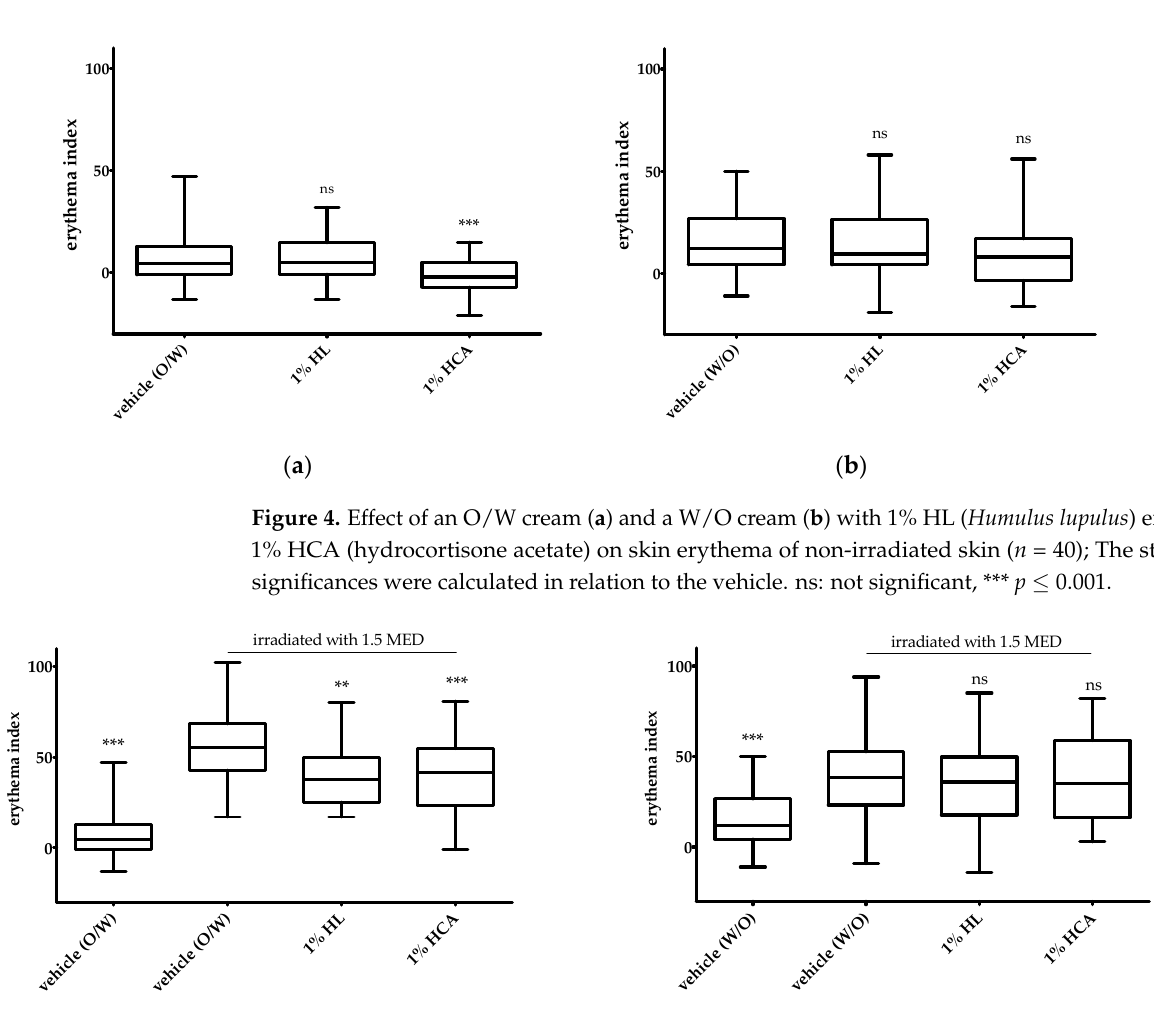
Figure 5. Effect of an O/W cream ( a ) and a W/O cream ( b ) containing 1% HL ( Humulus lupulus ) extract or 1% HCA (hydrocortisone acetate) on skin erythema of human skin irradiated with 1.5- fold MED UVB ( n = 40); The statistical significances were calculated in relation to the irradiated vehicle; ns: not significant, ** p ≤ 0.01, *** p ≤ 0.001.